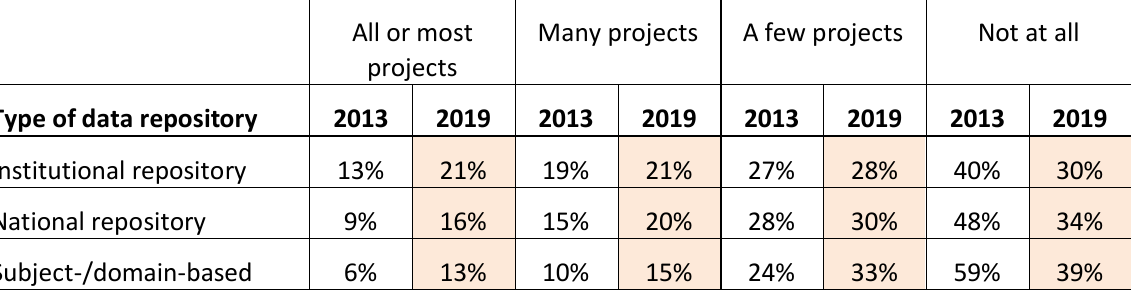
Table 8 : Comparison of the results for data published through accessible repositories. Respondents 2019: N=457,451,437; respondents 2013: N=521,521,516 (ARIADNE 2014: 102, Figure